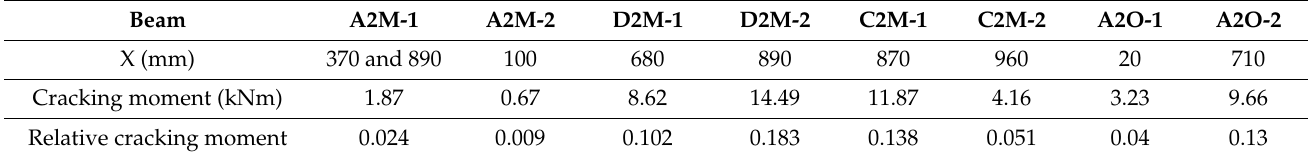
Figure 27. Crack formation and density under loading—beam A2C-2. Table 9. Location of the first crack and the value of the cracking moment for beams in